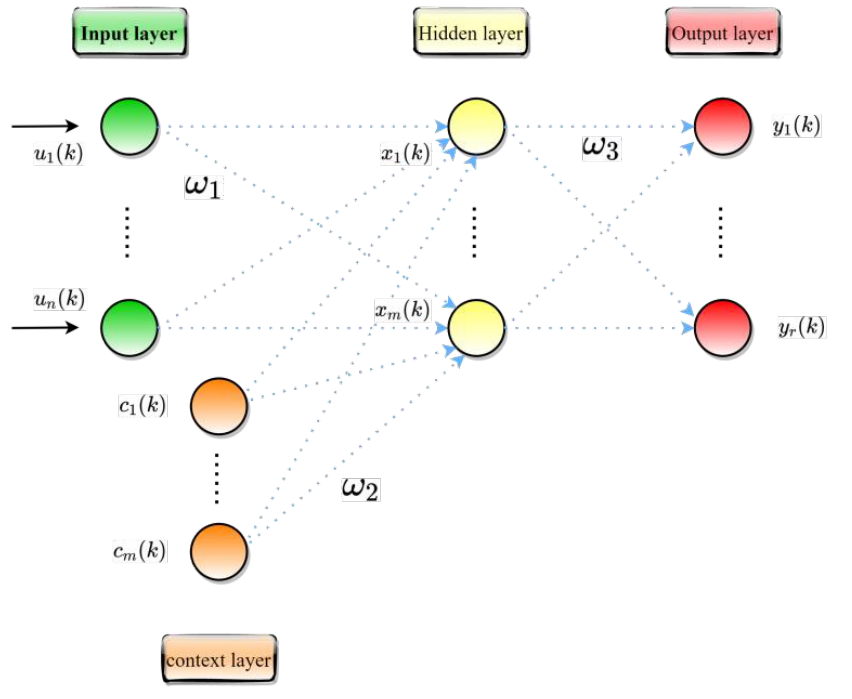
Figure 6. The structure of ELMAN.